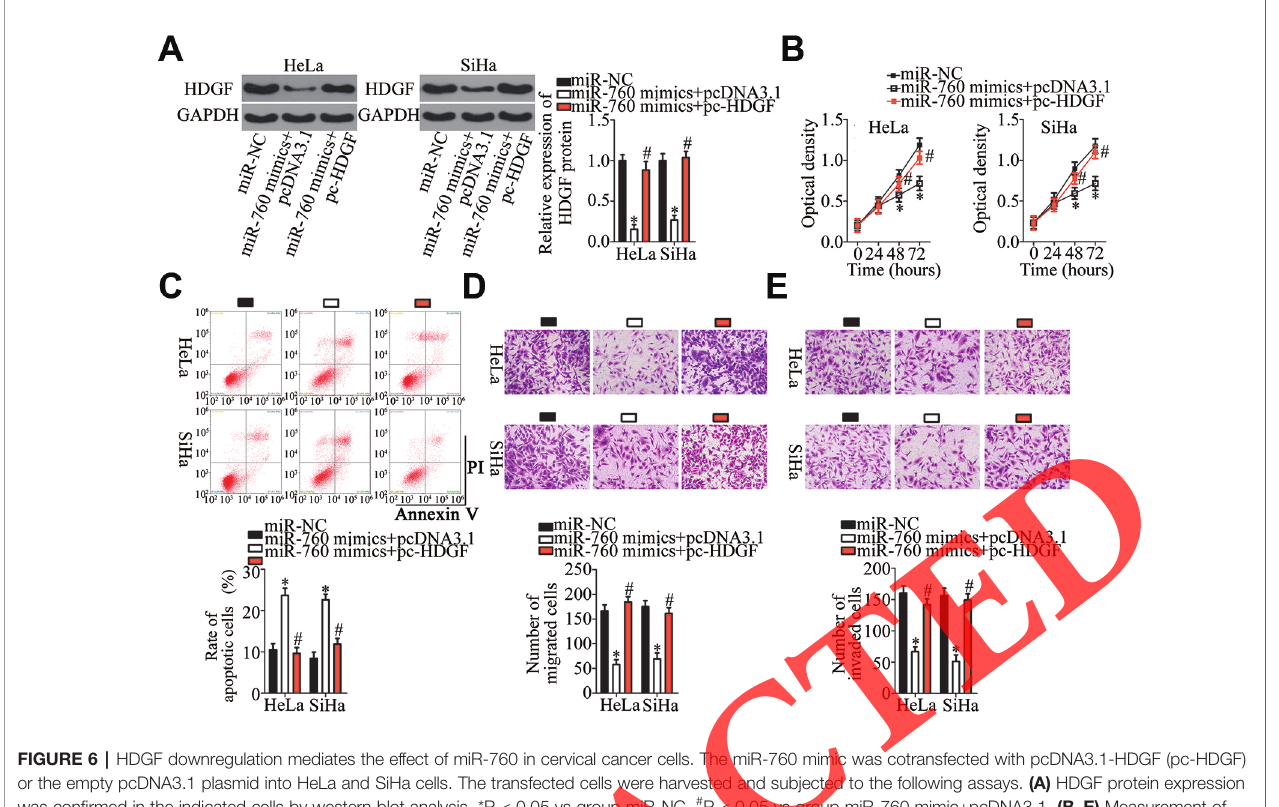
FIGURE 6 | HDGF downregulation mediates the effect of miR-760 in cervical cancer cells. The miR-760 mimic was cotransfected with pcDNA3.1-HDGF (pc-HDGF) or the empty pcDNA3.1 plasmid into HeLa and SiHa cells. The transfected cells were harvested and subjected to the following assays. (A) HDGF protein expression was con fi rmed in the indicated cells by western blot analysis. *P < 0.05 vs group miR-NC. # P < 0.05 vs group miR-760 mimic+pcDNA3.1. (B – E) Measurement of proliferation, apoptosis, migration, and invasiveness of the above-mentioned cells was performed by the MTT assay, fl ow cytometry, and migration and invasion assays, respectively. *P < 0.05 vs the miR-NC group. # P < 0.05 vs the miR-760 mimic+pcDNA3.1